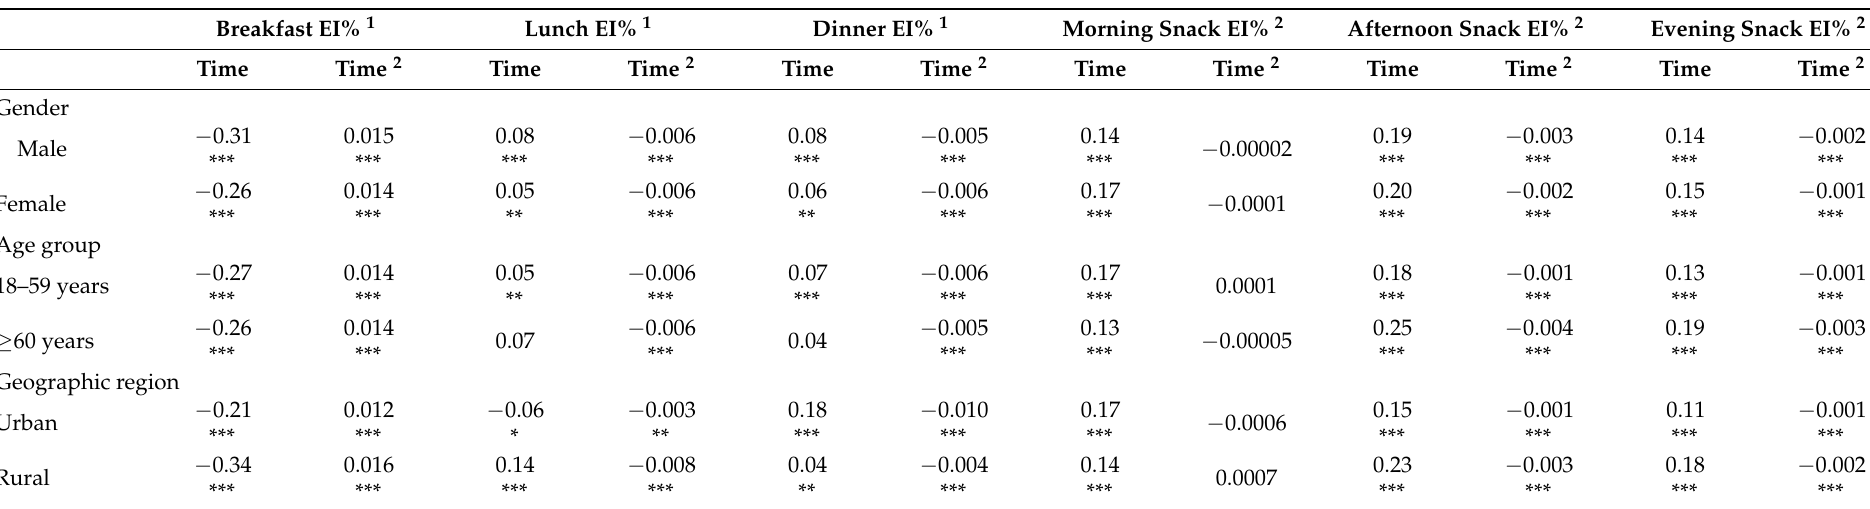
Table 4. Trend analysis of energy proportions of eating occasions by gender, age-group and location in study sample from 1991 to